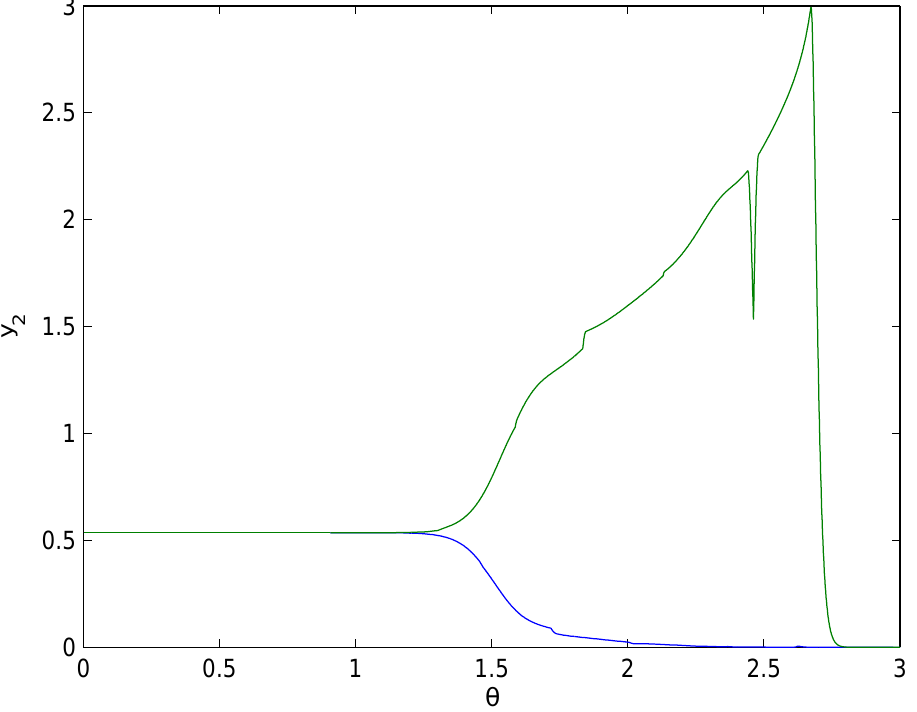
Figure 8. Bifurcation figure of model (63): the relation of t and y 2 . The bifurcation value is approxi- mately equal to